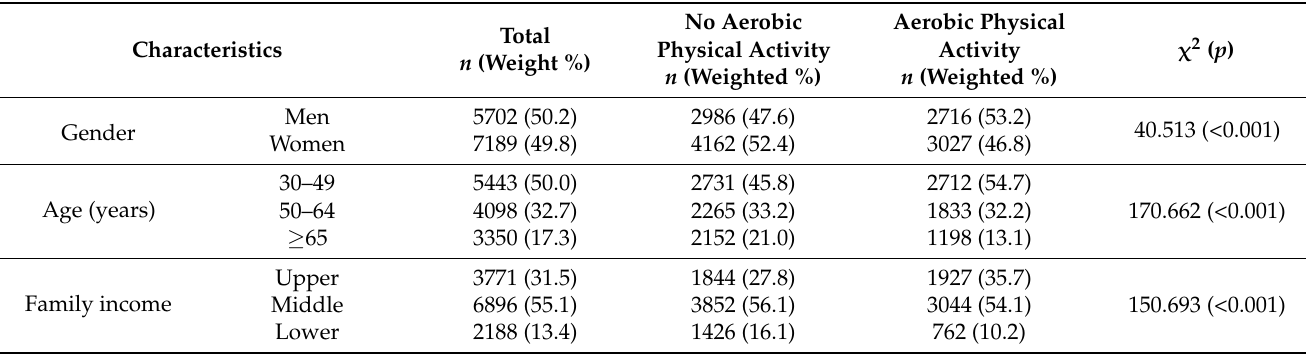
Table 1. Comparison of the no aerobic physical activity and aerobic physical activity groups regarding sociodemographic characteristics ( n =